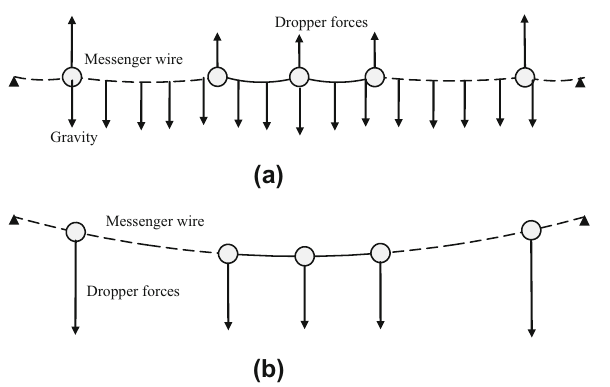
Fig. 2 Separate model method: a contact wire-dropper sub-system; b messenger wire